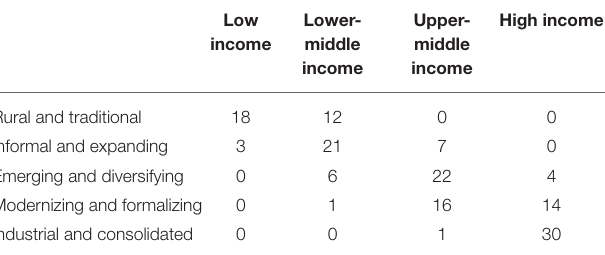
TABLE 3 | Food system typology vs. income group